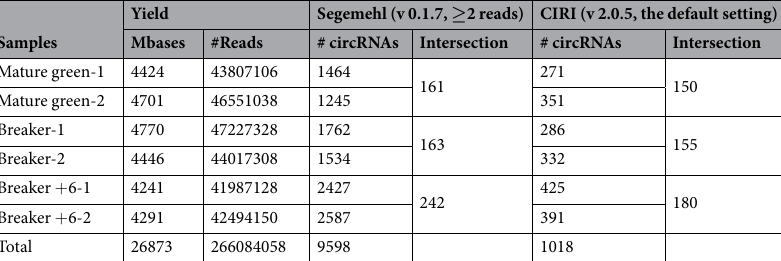
Table 1. Yield of deep sequencing and putative back-splice sites detected.